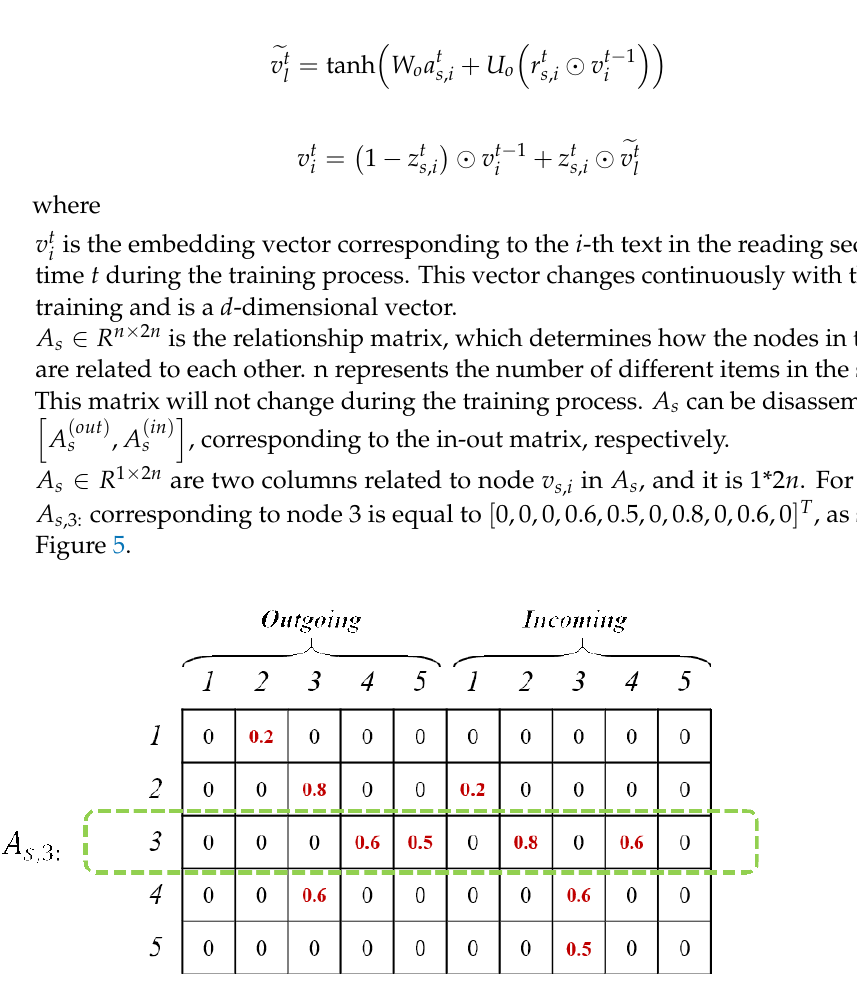
Figure 5. Example of A s ,3: